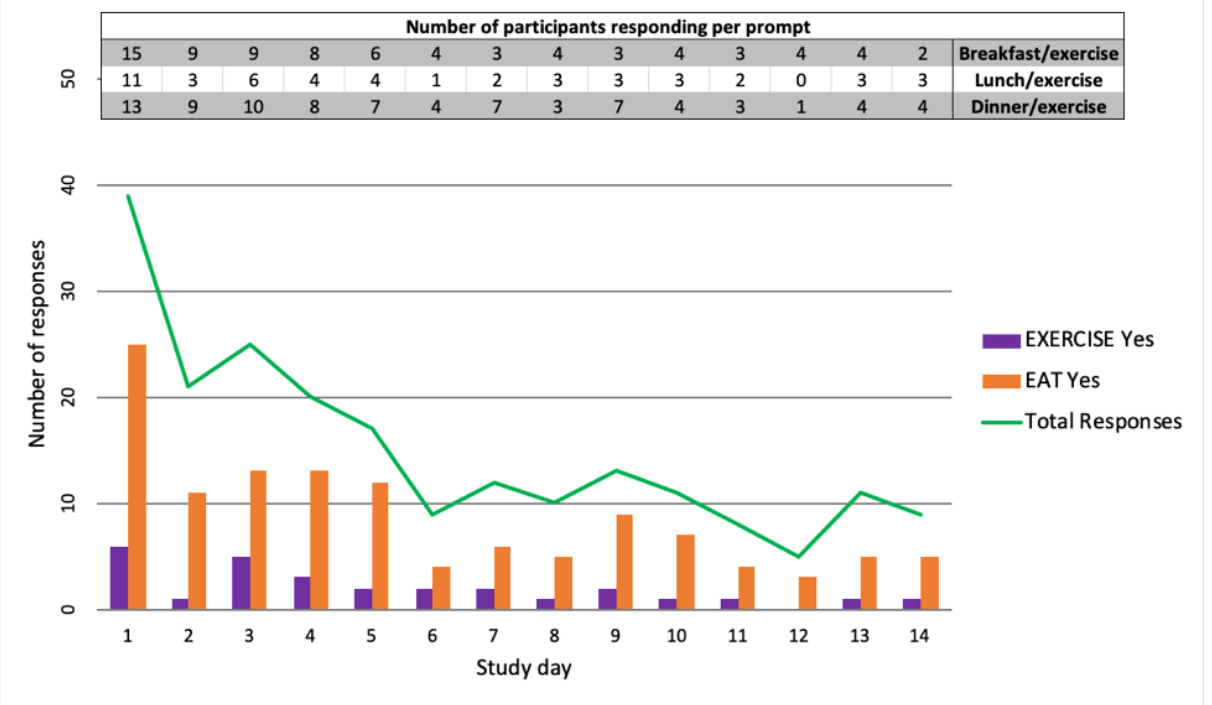
Figure 1. Overall study engagement shown by the number of total responses per day (green line), and “yes” responses per day for eating (orange bars) and exercise (purple bars). The table presents raw numbers of responses per day based on mealtime.